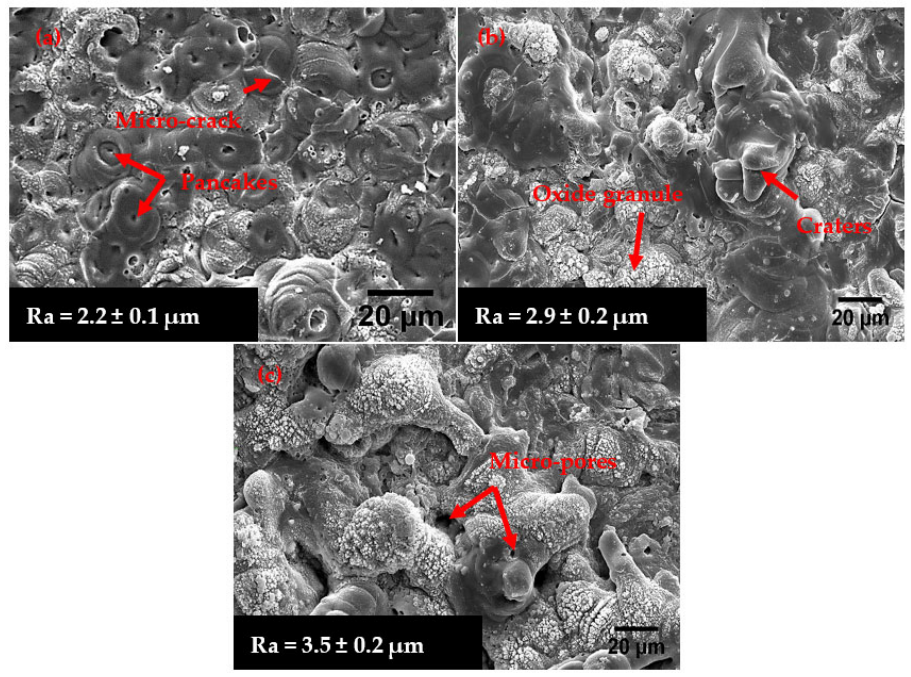
Figure 2. FESEM surface morphology images of the coatings prepared in solutions containing dif ‐ ferent Na 2 MoO 4 concentrations: ( a ) Mo ‐ 0, ( b ) Mo ‐ 3, and ( c ) Mo ‐ 5. different Na 2 MoO 4 concentrations: ( a ) Mo-0, ( b ) Mo-3, and ( c )